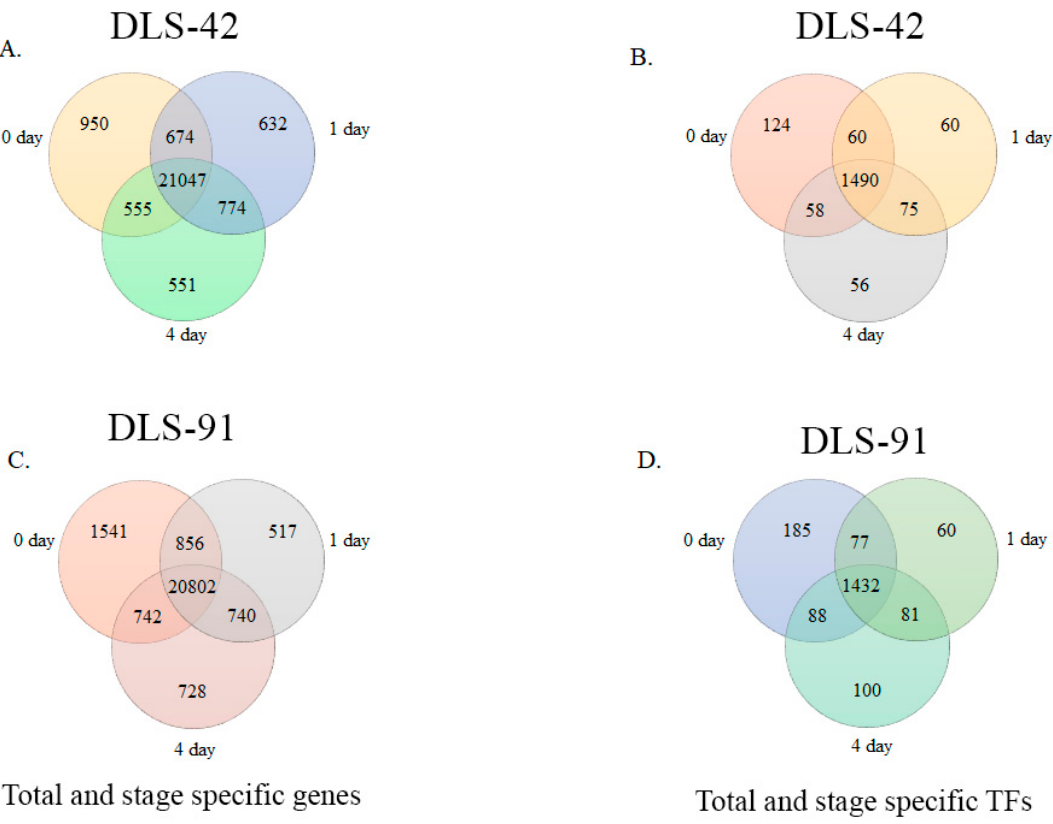
Figure 3. Venn diagram analysis of DLS-42 and DLS-91 transcriptome data. ( A , C ) Venn diagrams of total and stage-specific genes. ( B , D ) Venn diagrams of total and stage-specific transcription factors predicted in DLS-42 and DLS-91 leaf tissues.